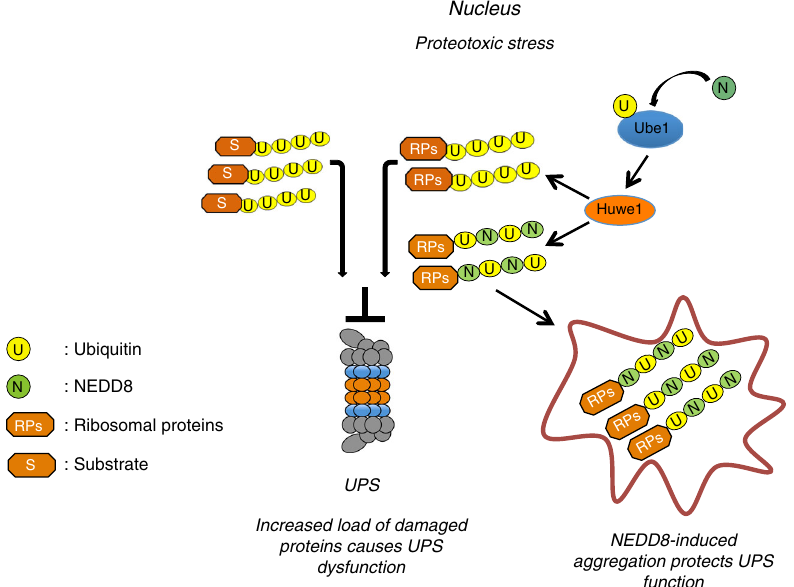
Fig. 10 Model for the role of NEDDylation in nuclear proteotoxic stress response. Upon proteotoxic stress the load of misfolded ubiquitinated proteins is increased compromising the function of UPS. The activation of NEDD8 by the ubiquitin E1 enzyme UBA1 and its conjugation by E3-ligases such as HUWE1 results in the modi fi cation of substrates with NEDD8 and ubiquitin possibly with hybrid NEDD8/ubiquitin chains. This provides a regulatory pathway to prevent substrate targeting to the proteasome, promoting the transient aggregation of a group of proteins. This protects the UPS from the stress-induced